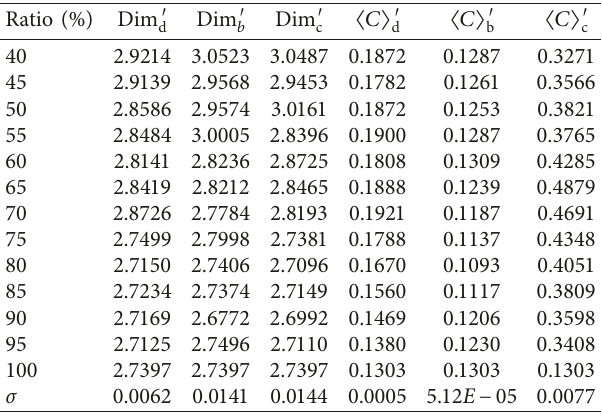
Table 7: Box dimension and cluster coefficient of YPI network with nodes removal in the ascending order. Ratio (%) Dim d